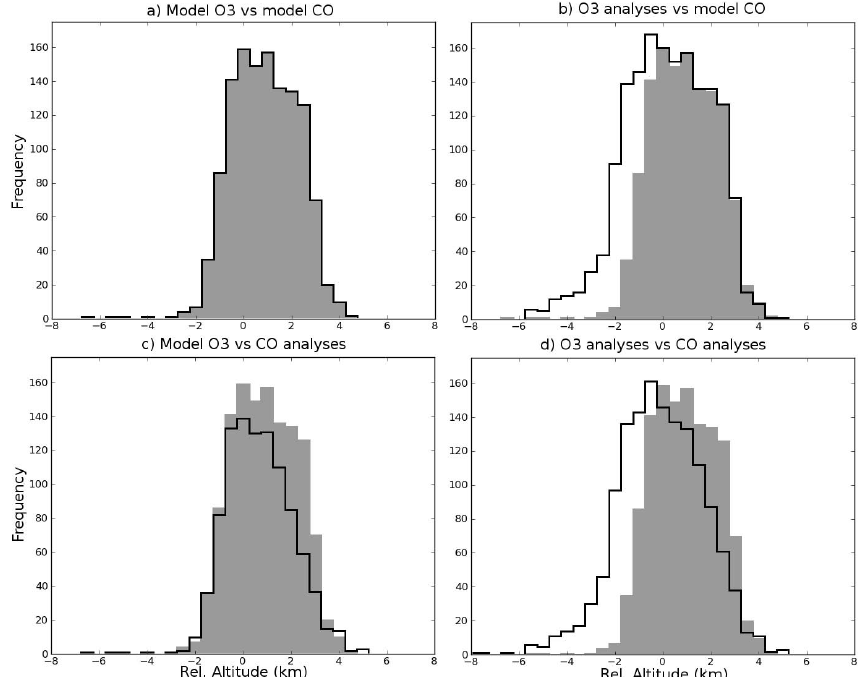
Fig. 5. Histograms showing the distributions of the ExTL in relative altitude space in the region between 30 ◦ W–10 ◦ E and 40–65 ◦ N on 15 August 2007 at 12:00UTC. model O 3 vs. model CO (a) , O 3 analyses vs. model CO (b) , model O 3 vs. CO analyses (c) and O 3 analyses vs. CO analyses (d) are displayed in black, and model O 3 vs. model CO distribution is overplotted in gray on the plots. The histograms display the absolute